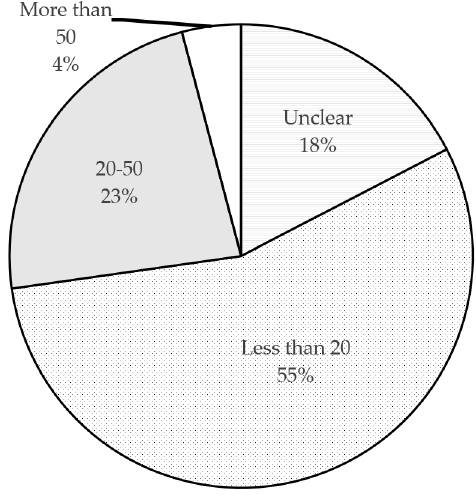
Figure 4. The number of drug packages stored in homes.